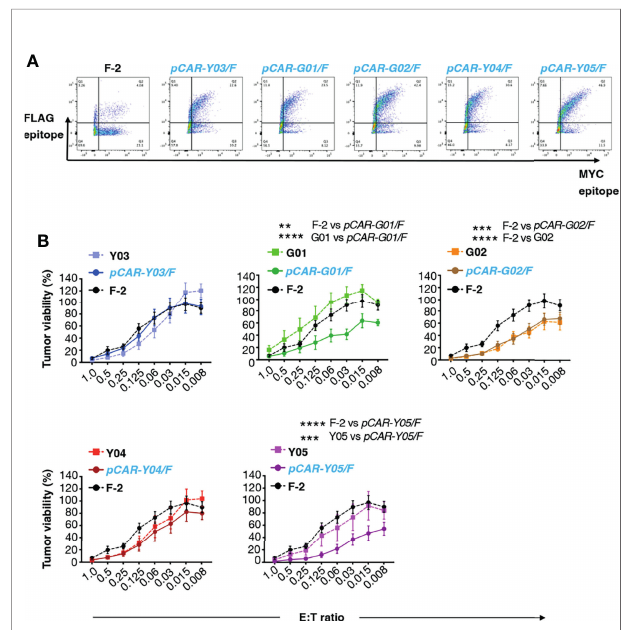
FIGURE 4 | Evaluation of cytolytic activity of pCARs targeted against CD19. (A) Human T-cells were engineered by retroviral transduction to express the indicated pCARs, or F-2 CAR as control. Permeabilized T-cells were incubated with antibodies directed against embedded MYC (CAR) and FLAG (CCR) epitope tags and then analyzed by fl ow cytometry. Data are representative of three independent replicate experiments. (B) CAR or pCAR T-cells were co-cultivated with ffLuc/RFP + Nalm-6 leukemia cells at the indicated E:T ratio. Target viability was quanti fi ed after 72h (mean ± SEM, n=7 replicates from 5 donors). Statistical analysis was performed using two-way ANOVA. ** p < 0.01; *** p < 0.001; **** p <